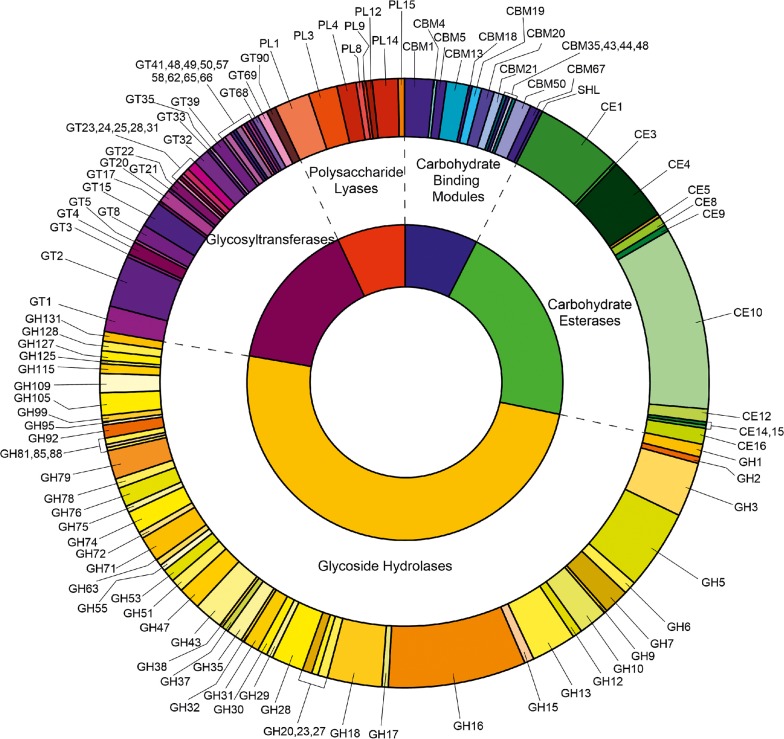
C. purpureum CAZy genes classification (except auxiliary activities of oxidoreductases from AA1 to AA9).